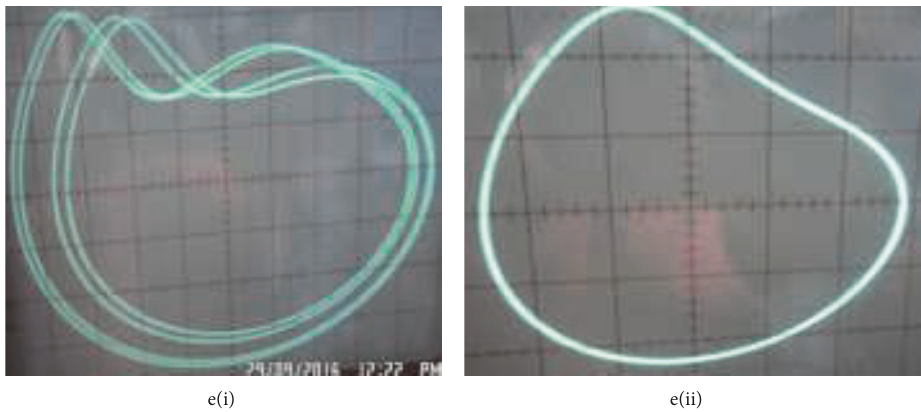
Figure 10: Experimental phase portraits showing the coexistence of multiple (two) solutions for different values of the control parameter 𝑅 ( i.e., 𝜇) . We have five pairs of mismatch coexisting asymmetric solutions: (a) screw-like (Shilnikov) chaotic attractor a(i) coexisting with a 3 spiralling- like (Feigenbaum) chaotic attractor a(ii) for 𝑅 3 = 9.09 k ( i.e., 𝜇 = 1.100) ; (b) screw-like (Shilnikov) chaotic attractor b(i) coexisting with a period-2 cycle b(ii) for 𝑅 3 = 8.85 k ( i.e., 𝜇 = 1.130) ; (c) period-3 cycle c(i) coexisting with a period-1 cycle c(ii) for 𝑅 3 = 8.33 k ( i.e., 𝜇 = 1.200) ; (d) screw-like (Shilnikov) chaotic attractor d(i) coexisting with a period-1 cycle d(ii) for 𝑅 (e) period-4 cycles e(i) coexisting with a period-1 cycle e(ii) for 𝑅 3 = 7.63 k (i.e., 𝜇 = 1.310 ). Each pair of solutions appears randomly in experiment when switching on and off the power supply. The scales are 𝑋 = 0.2 V/div and 𝑌 = 0.2 V/div for all pictures. Note the perfect similarity of those pictures with the numerical phase portraits of Figure